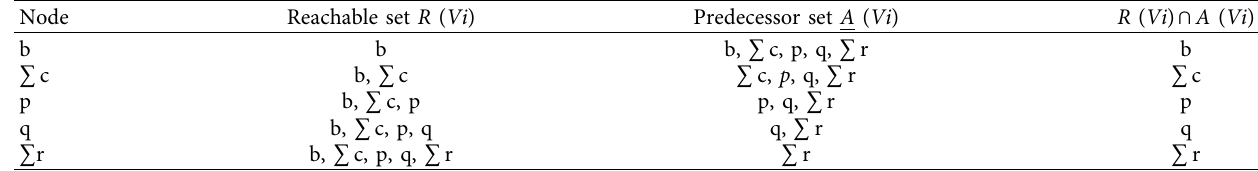
Table 6: Reachable set, predecessor set, and their intersection.